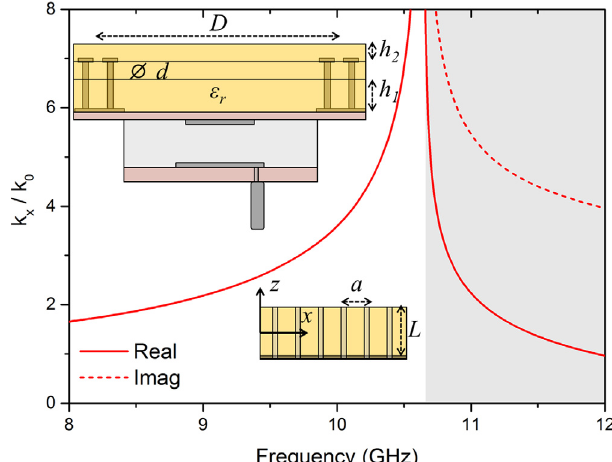
Figure 5. Frequency evolution of the x -component of the real (solid line) and imaginary part (dashed line) wave vector of a TM surface wave which propagates along a fakir’s bed of nails with length L = 4.75 mm, separation distance of a = 2.38 mm and host dielectric permittivity of e r = 2.2. Insets: Bottom: Fakir’s bed of nails analyzed. Top: Metaradome placed on top of one antenna element. Dimensions: D = 19 mm; d = 0.4 mm; h 1 = 3.175 mm; h 2 = 1.575